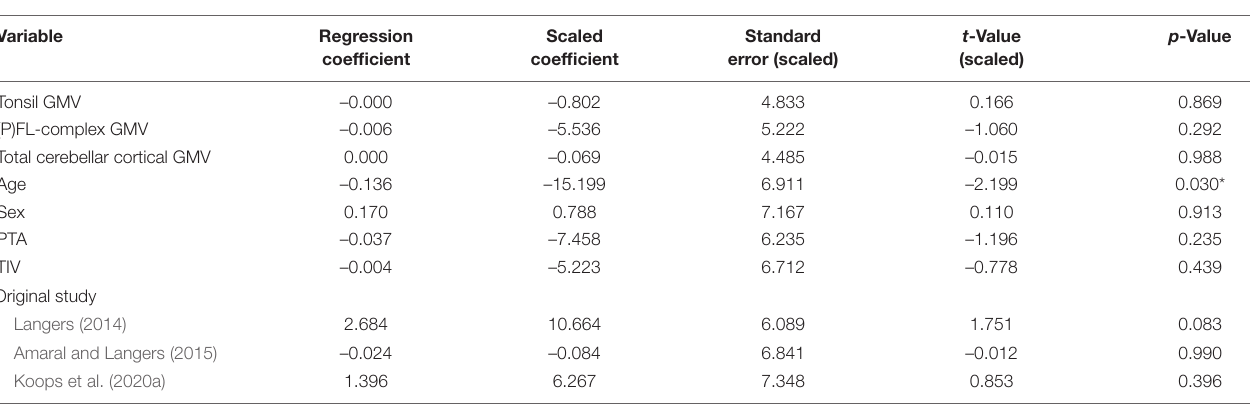
TABLE 4 | Ridge linear regression on outcome variable THI